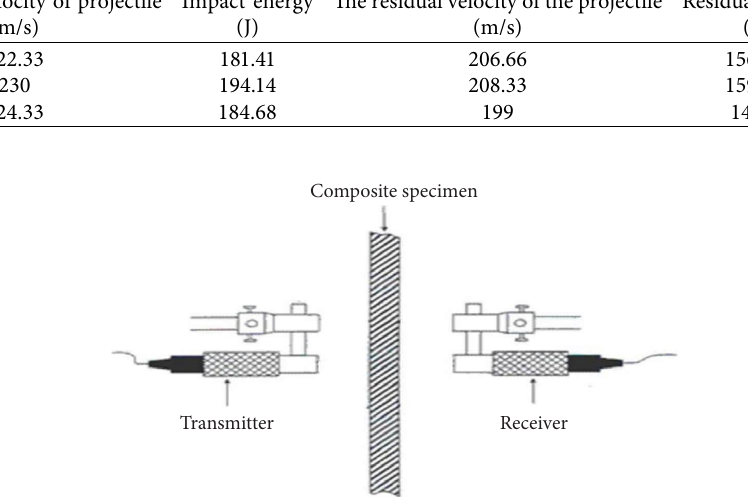
Figure 10: Simplifed diagram of the immersion scan system.